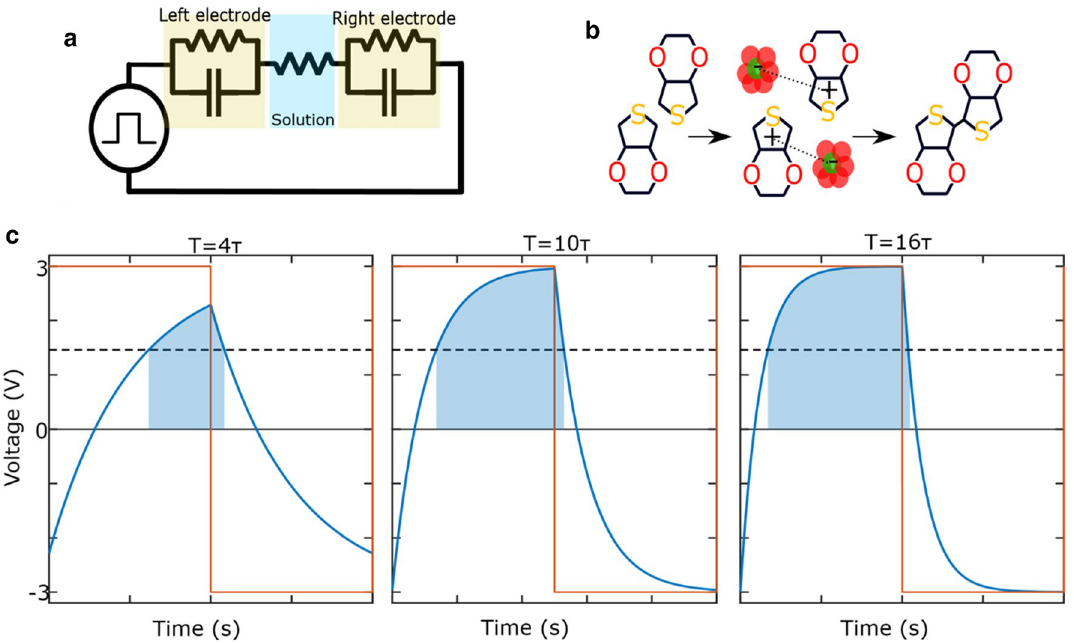
Fig. 5 The equivalent circuit used to model the charge accumulation at the interface ( a ). The reaction mechanism considered to model the polymerization rate: The monomer is oxidized at the cathode-electrolyte interface, forming a radical monomer cation; Neutralization occurs via an anion. This stabilization process is key for the final conductive state of the polymer: the excess negative charge is given, in fact, by the dopant which determines the final conductivity of the network. Radical–radical reaction leads to the formation of large, insoluble oligom- ers ( b ). The voltage transient at the interface ( c ). The dashed line indicates the oxidation potential, and the blue area is used to calculate the amount of reacting